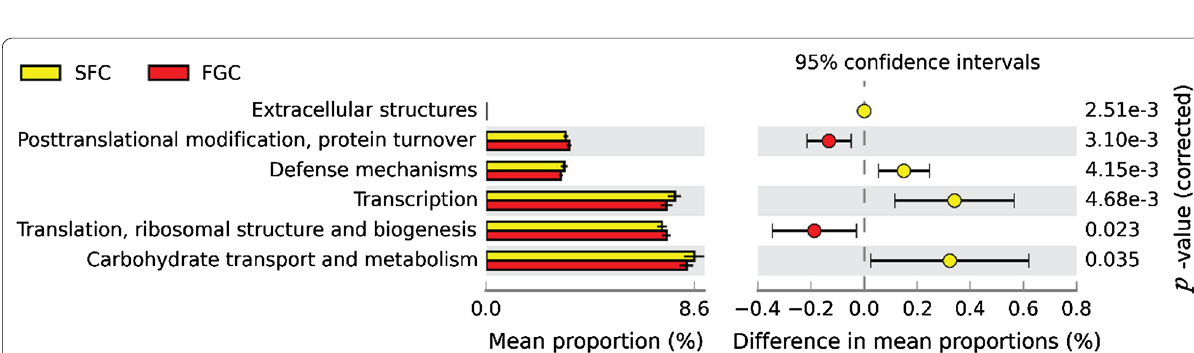
Fig. 5 Comparison of the distribution of the abundance of Kyoto Encyclopedia of Genes and Genomes (KEGG) pathways of rumen bacterial community for heifers fed steam flaked corn (SFC) or finely ground corn (FGC) diets. Only the significantly affected KEGG pathways by dietary treatments are